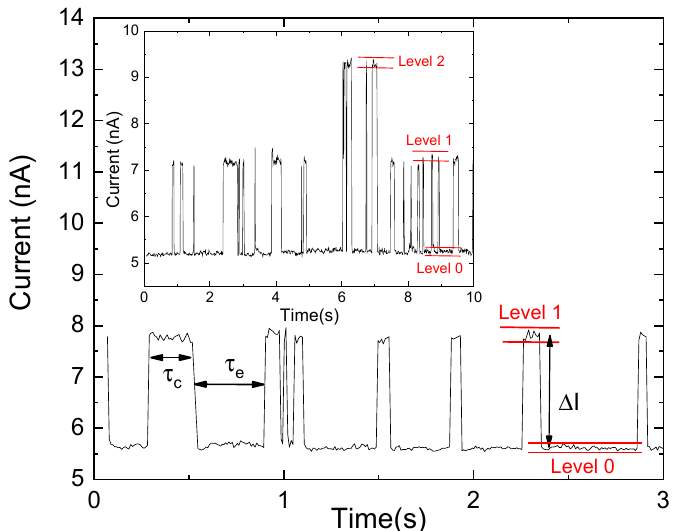
Figure 1. Current versus time trace for a Ni/HfO 2 /Si device in the high resistance state HRS, in which the RTN noise can clearly be seen. A two-level signal is shown; the two different current levels are marked with the corresponding current thresholds. Another RTN trace is shown in the inset, measured for the same device. Three current levels are seen in this case.